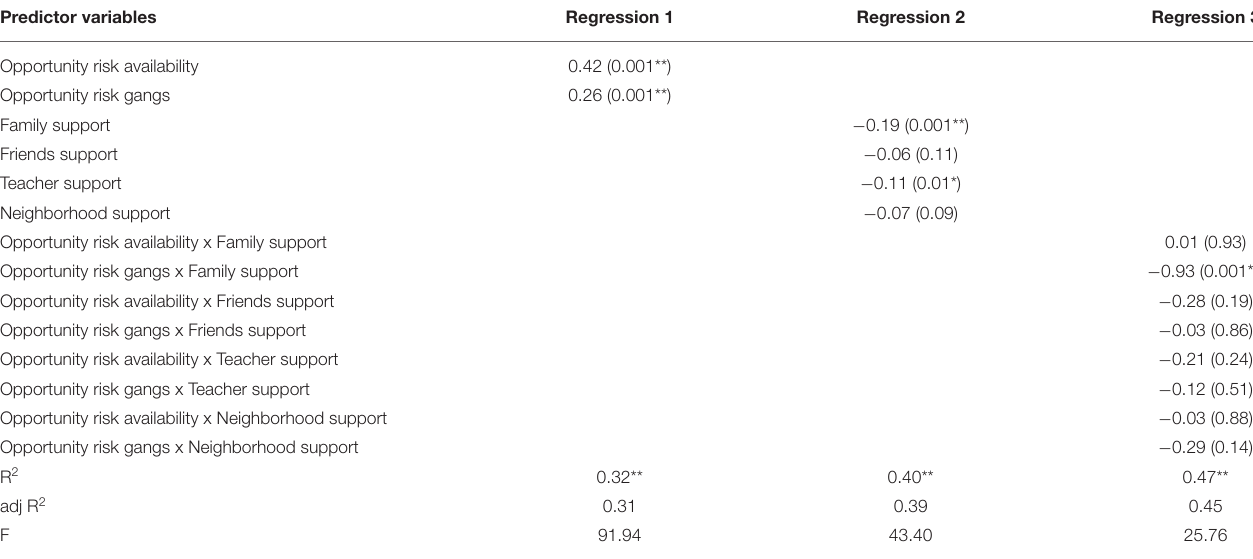
TABLE 3 | Results of hierarchical multiple linear regression analyses for availability and support and interaction between these variables in their effects on delinquent behaviors ( n =